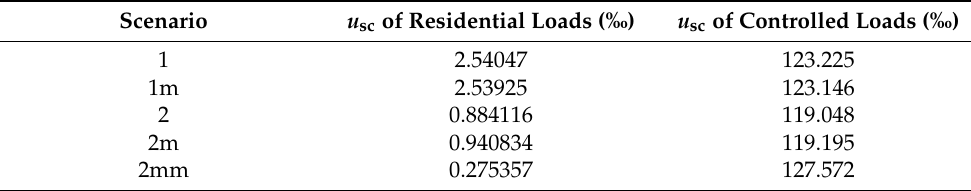
Table 2. Uncertainty values of residential and controlled datasets for the